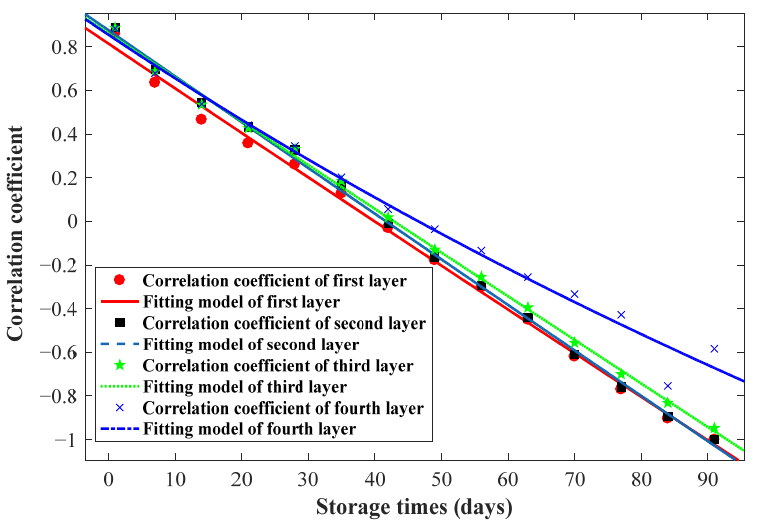
Figure 3. Model of the correlation coefficient threshold for grain temperature under different storage times.